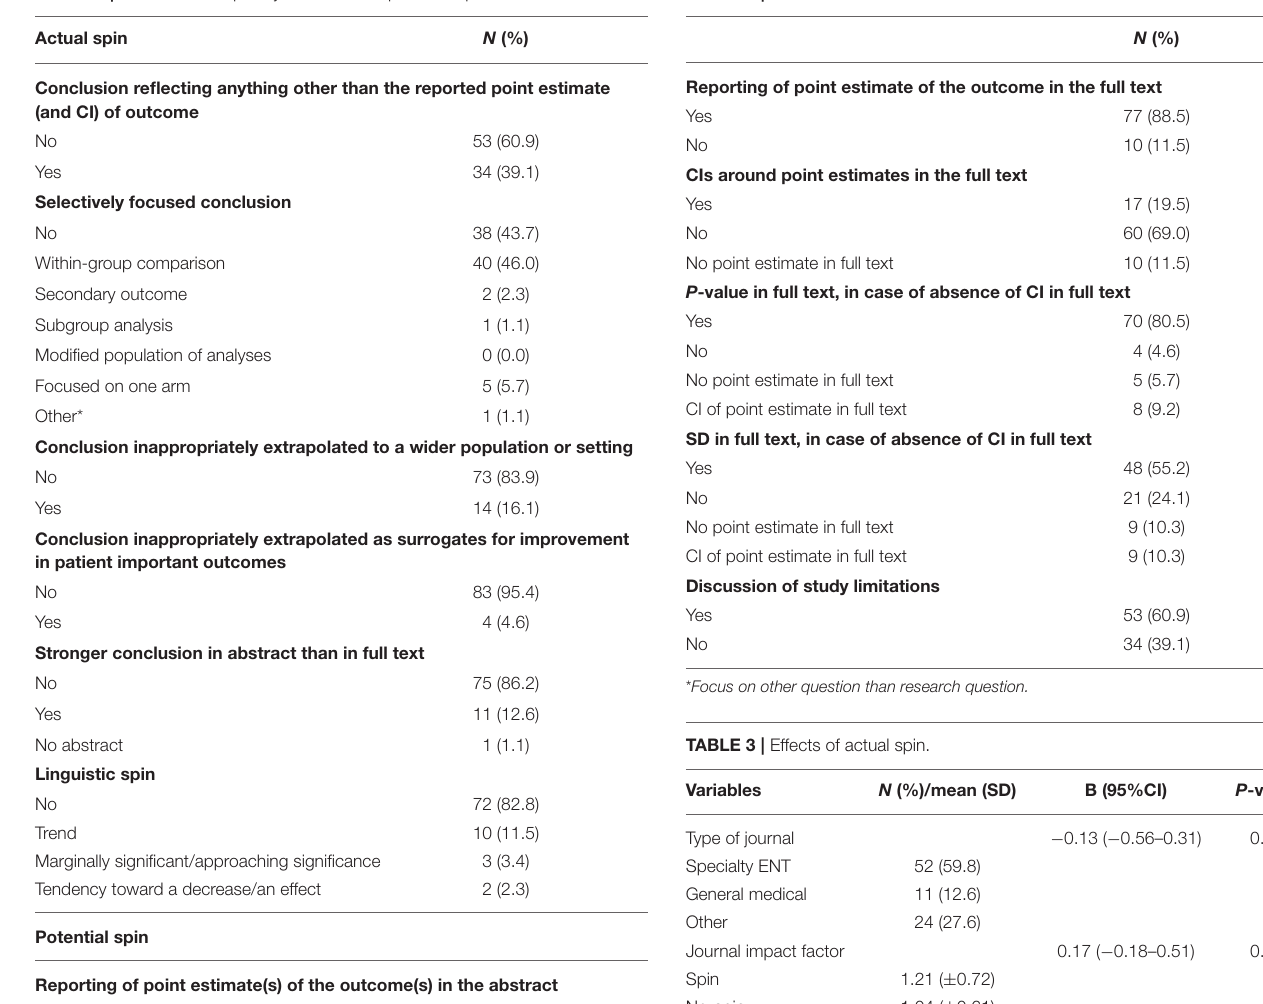
TABLE 2 | Nature and frequency of actual and potential spin.